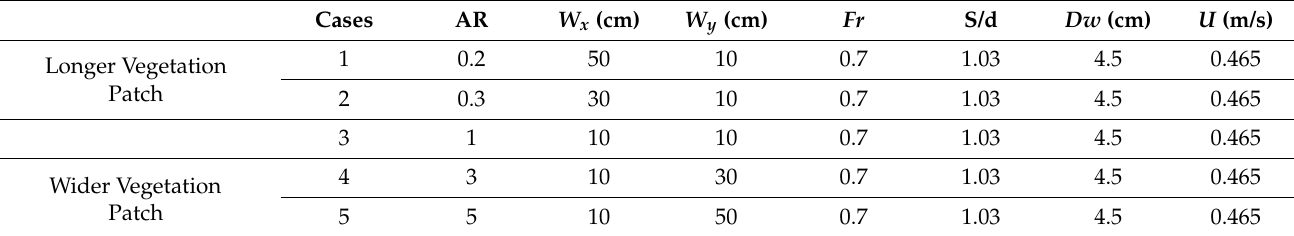
Figure 1. Layout of the domain for numerical simulation: Arrangement of the Vegetation patches. Table 1. Hydraulic Conditions of Numerical Model: Note: W x represents vegetation length; W y U (cid:46) (cid:112) depicts vegetation width; Fr shows Froude number ( Fr = gh , where U represents the initial flow velocity, g is the gravitational constant and h is the initial water depth); Dw stands for water depth; U is the initial velocity.